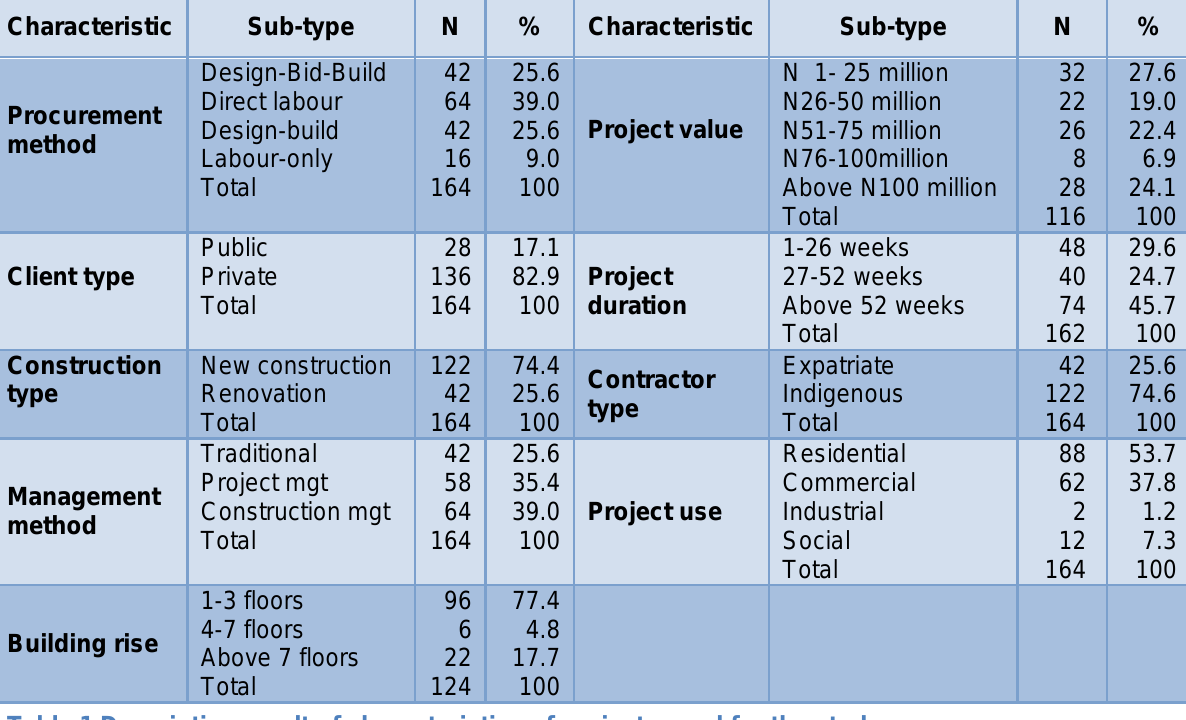
Table 1 Descriptive result of characteristics of projects used for the study